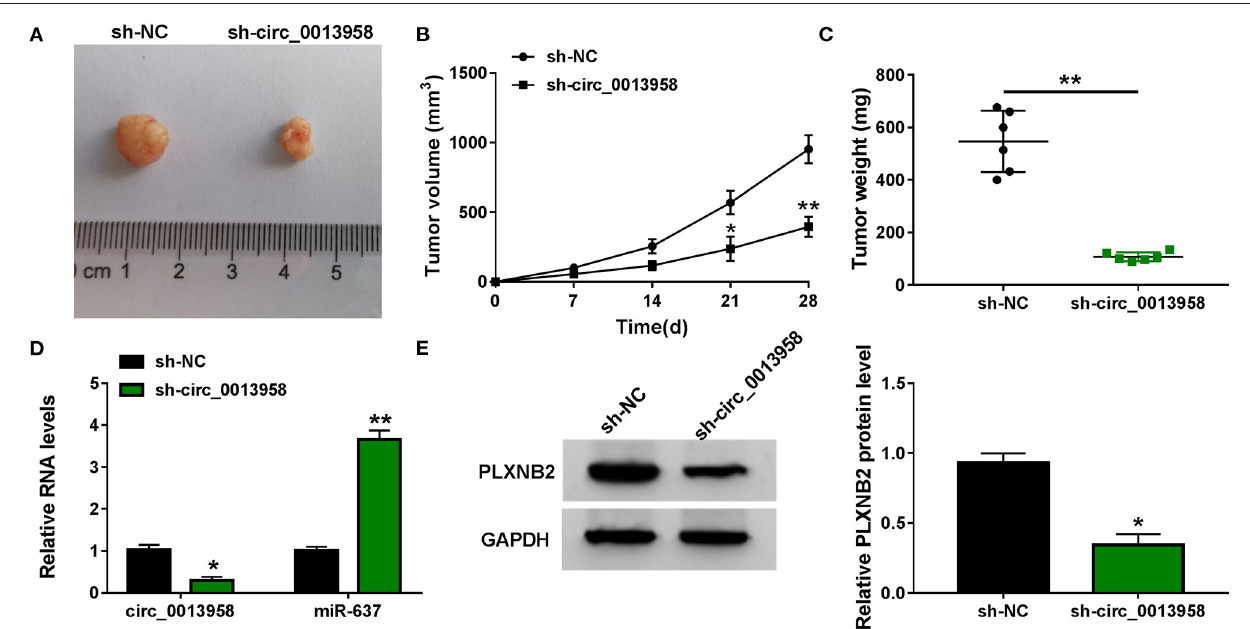
FIGURE 7 | Circ_0013958 silencing hampered OC tumor growth in vivo . SKOV3 cells stably expressing sh-NC or sh-circ_0013958 were subcutaneously injected into BALB/c nude mice ( n = 6). (A) Representative images of xenograft tumor tissues. (B) Tumor volume was measured every 7 days for 28 days. (C) Tumor weight was measured at 28-day post injection. (D) QRT-PCR analysis for the expression of circ_0013958 and miR-637 in xenograft tumor tissues. (E) Western blot assay for the protein level of PLXNB2 in xenograft tumor tissues. * P < 0.05; ** P <